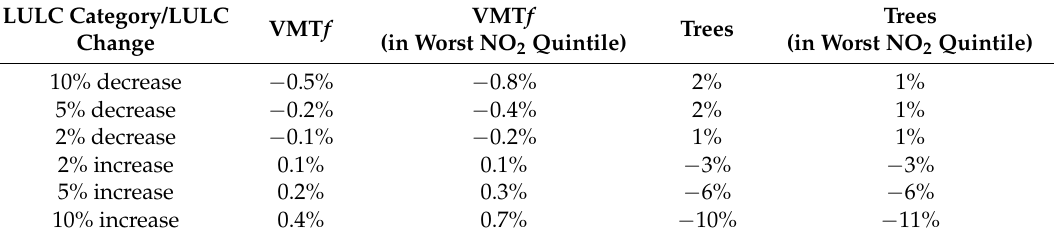
Table 5. Estimated change in the incidence of NO 2 -related asthma exacerbation associated with modifications to the two LULC categories VMTf and